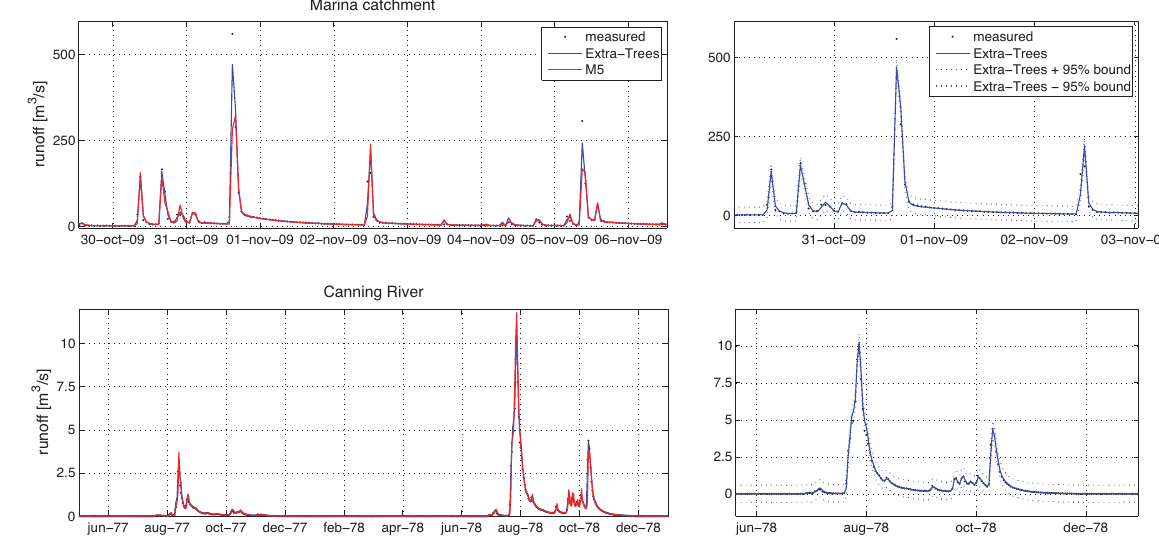
Fig. 7. Comparison between the measured and predicted streamflow (with Extra-Trees and M5) for Marina catchment and Canning River (left panels), and comparison between measured and predicted streamflow with Extra-Trees and 95% confidence bounds (right panels).